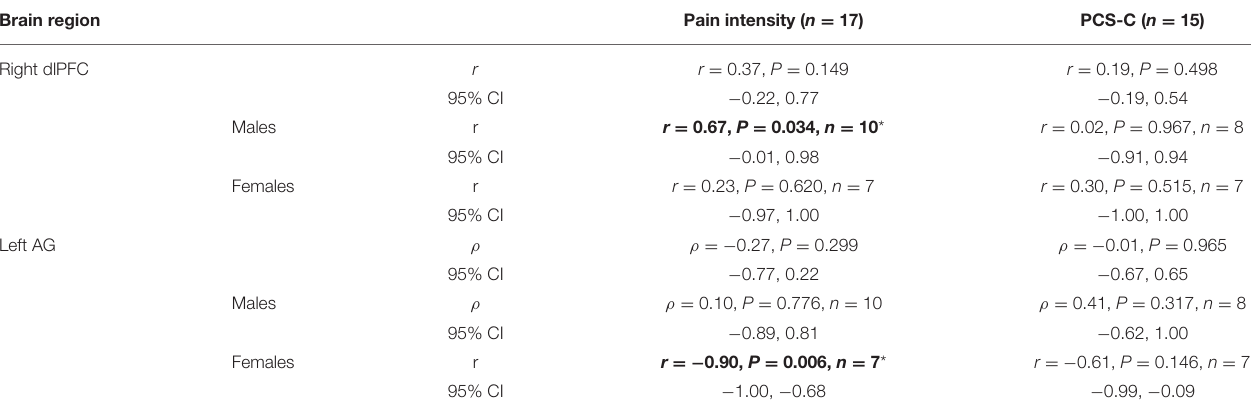
TABLE 5 | Correlations between right amygdala rsFC and clinical measures in adolescents with NeuP. Brain